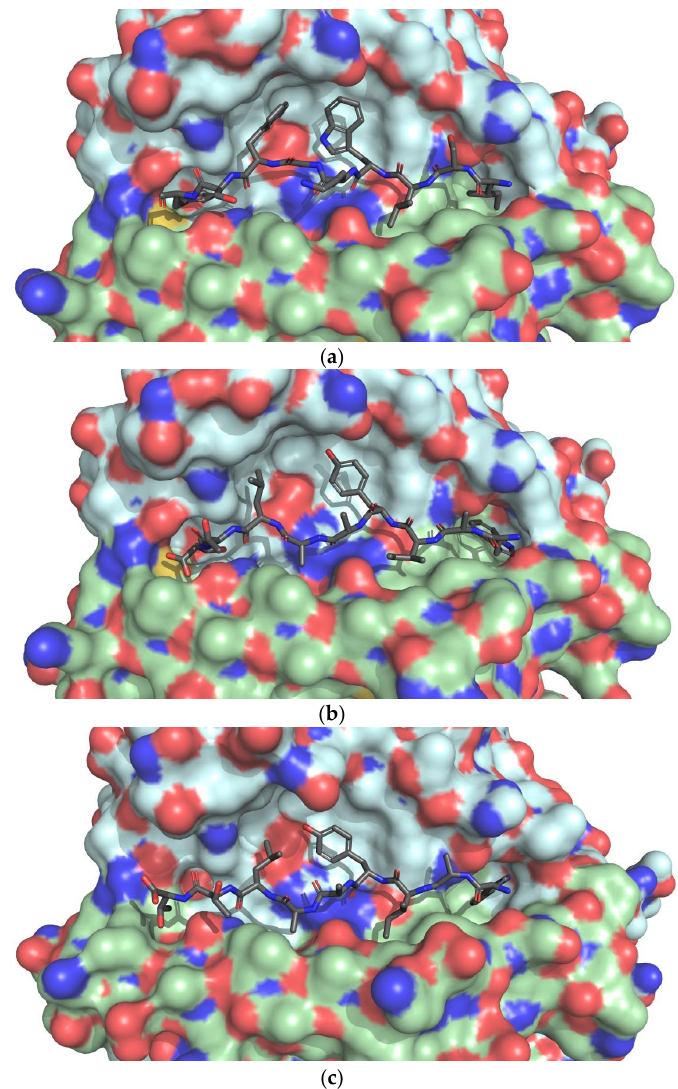
Figure 7. Conformational changes in MD simulation of WAIYAALTT- to HLA-DRA/DRB1*15:02. ( a ) Nine-mer core of a self-epitope from chain α3 type IV collagen (ISLWKGFSF), bound to HLA-DRA/DRB1*15:01 (PDB ID: 5V4M); ( b ) epitope WAIYAALTT docked to HLA-DRA/DRB1*15:02 (modeled from 5V4M); ( c ) epitope WAIYAALTT with HLA-DRA/DRB1*15:02 after 20 ns MD simulation. HLA chains α colored green and β blue.